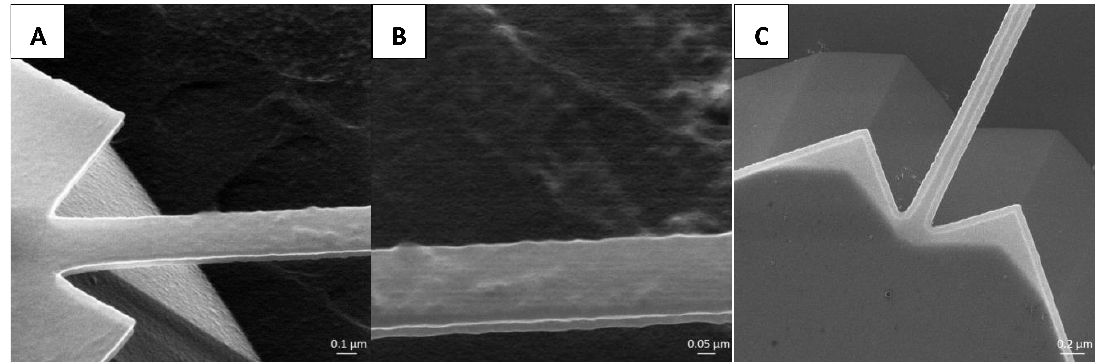
Figure 6. Helium ion micrographs of a SiCN resonator immobilized with anti-rabbit IgG and rabbit IgG with contrast to its pristine surface. Images taken at a 45° tilt angle ( A ) The protein distribution on SiCN nanoresonator anchoring pad and suspended nanostring; ( B ) High magnification view of protein coverage on the suspended nanostring; ( C ) Pristine surface of a SiCN nanoresonator before